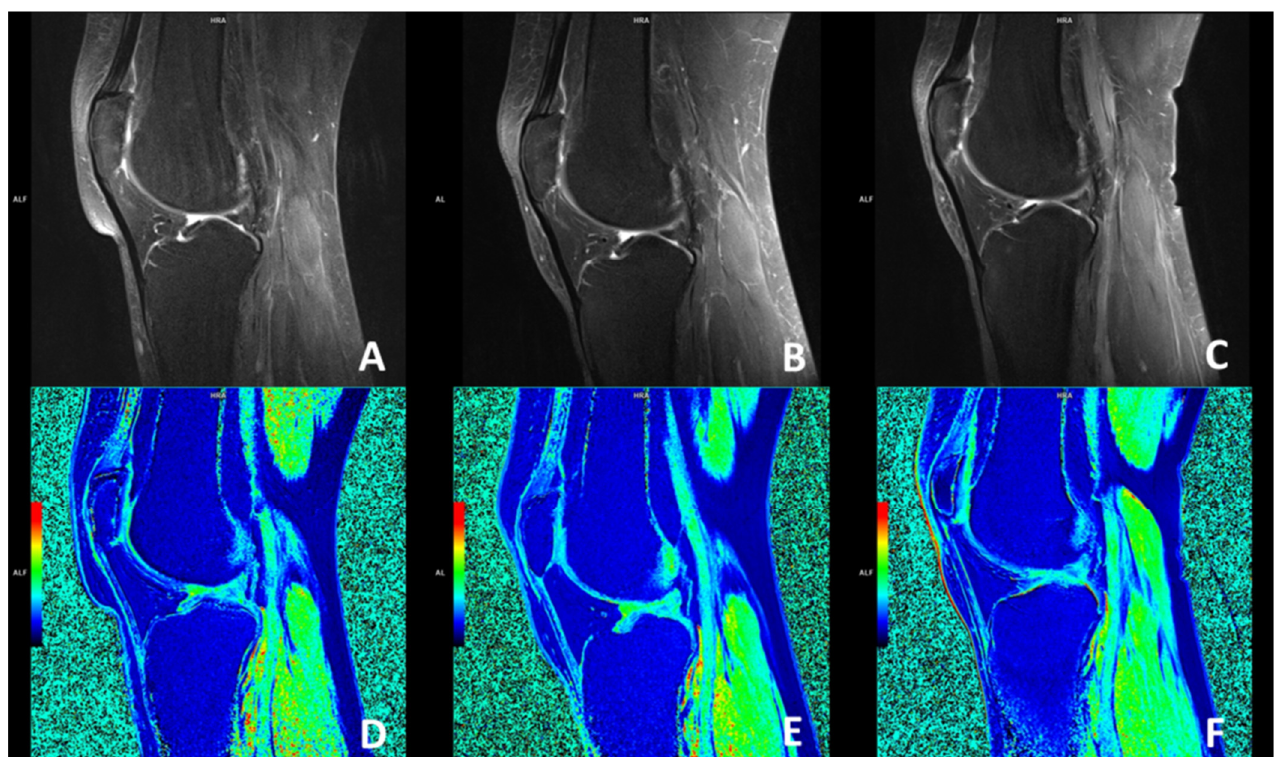
Figure 4. Sagittal MRI magnetic resonance imaging (MRI) slices through the center of the knee accessing the patellofemoral joint osteoarthritic changes using fat-suppressed proton-density-weighted turbo spin-echo method at baseline ( A ), 3 months ( B ), and 6 months ( C ) follow-ups with corresponding delayed gadolinium-enhanced MRI of the cartilage (dGEMRIC) images ( D – F ). No changes were seen when dGEMRIC indices were calculated.